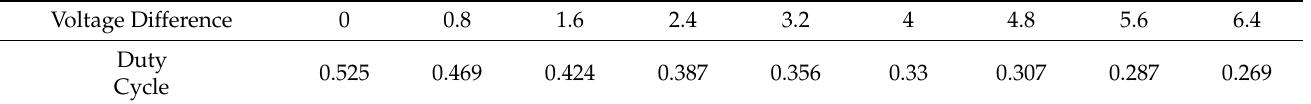
Figure 12. Variation of duty cycle with voltage difference. Table 2. Partial values of duty cycle at different voltage differences.